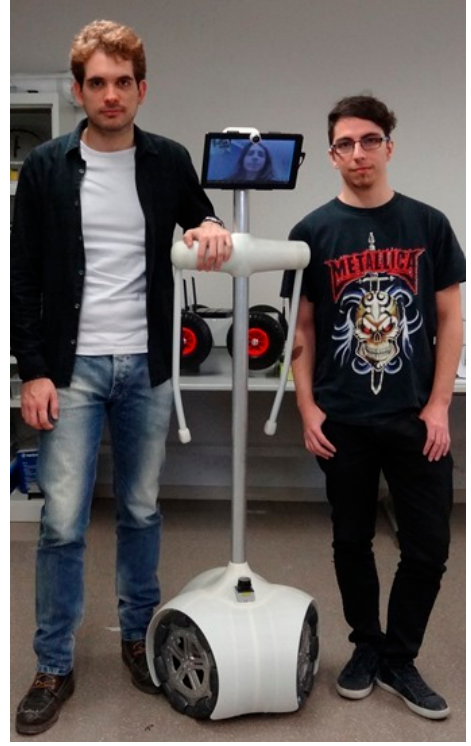
Figure 1. Comparative image of the APR.